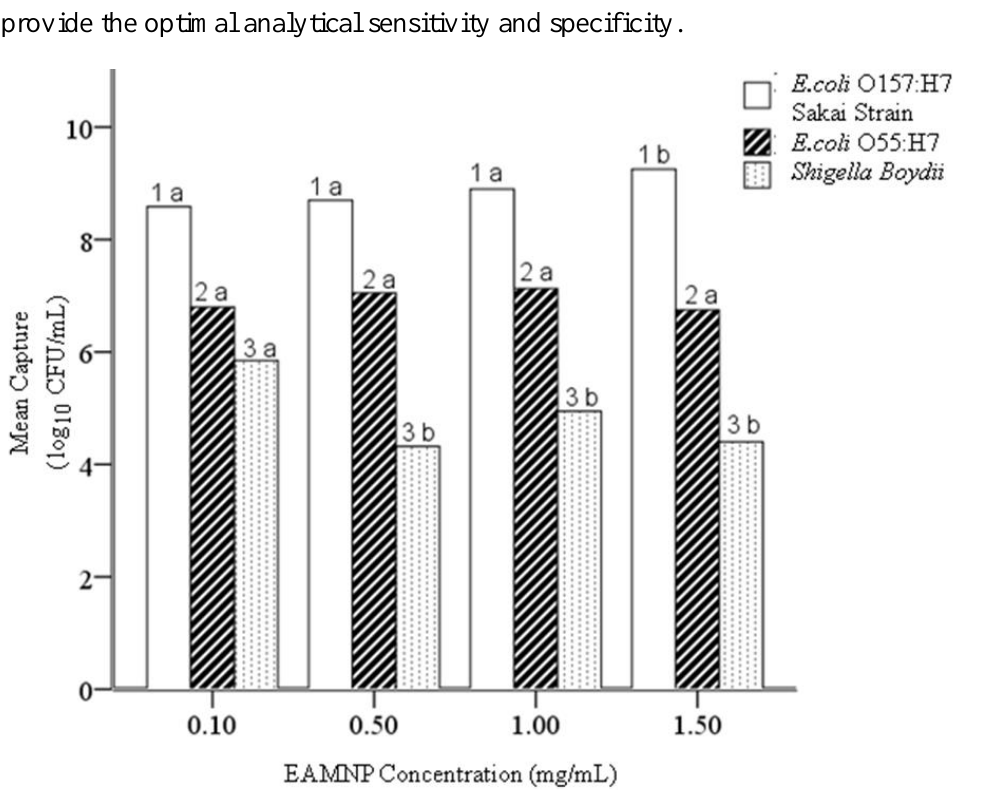
Figure 5. Mean concentration (log 10 of CFU/mL) of each bacterial culture captured in IMS, using Mab-EAMNPs, at concentrations of 1.5 mg/mL, 1.0 mg/mL, 0.5 mg/mL, and 0.1 mg/mL. Statistical comparisons were made within numbered groups (1–3), and letters (a or b) indicate significant differences (α = 0.05). Zero counts were estimated to facilitate analysis